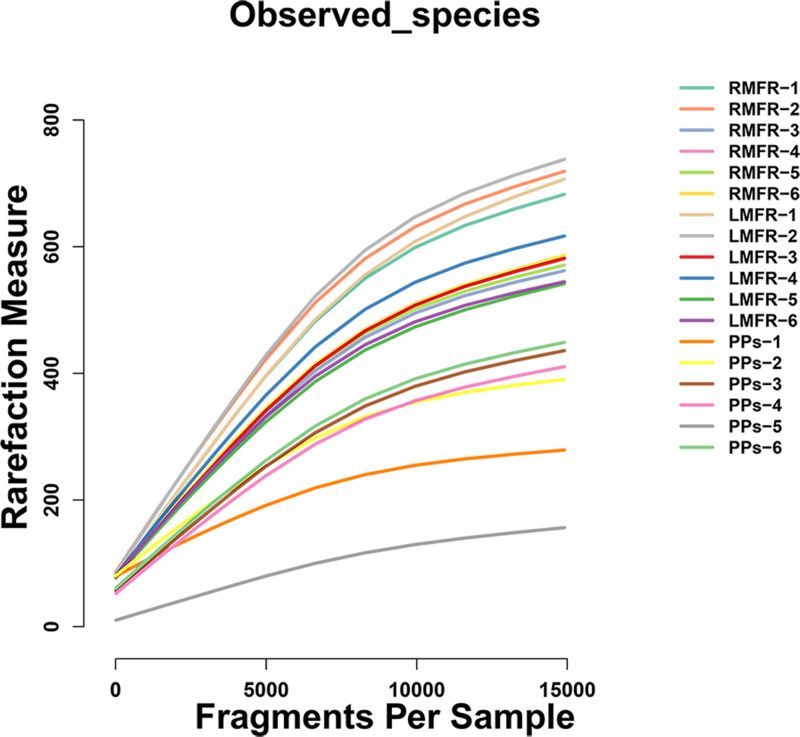
Rarefaction curves of each sample from LMFR, RMFR and ileal PPs of Bactrian camels calculated at the species level.Horizontal axis: the amount of effective sequencing data; vertical axis: the observed number of operational taxonomic units (OTUs). Total sample abundance estimates were calculated by abundance estimators Observed species. LMFR: longitudinal mucosal folds region; RMFR: reticular mucosal folds region; PPs: ileal Payer’s patches.